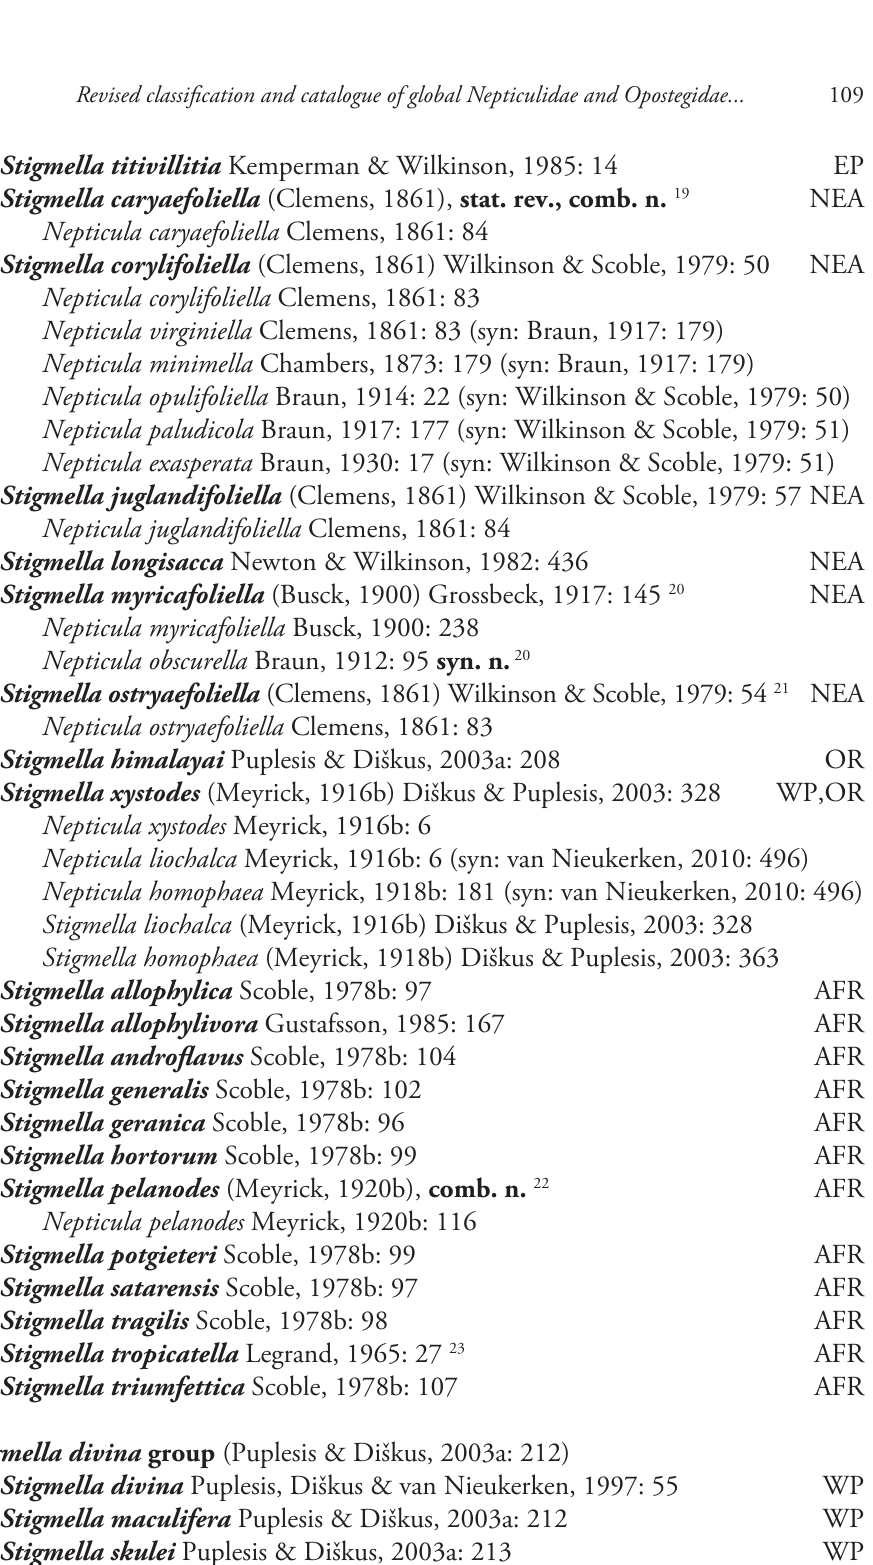
Stigmella titivillitia Kemperman & Wilkinson, 1985: 14